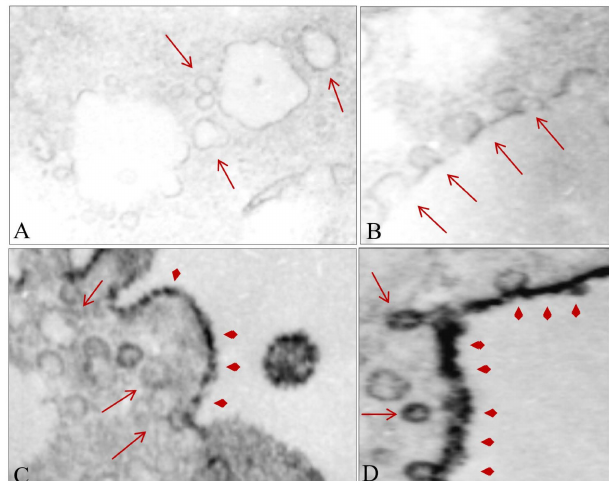
Figure 7. Effect of shock waves on cellular substructure. ( A ) Formation of new cytosolic vesicles after shock waves (arrows). ( B ) Growth of the cytosolic vesicles after incorporation of the smaller vesicles. ( C ) Growth in size and number of the newly formed cytosolic vesicles near the cell mem- brane. ( D ) Fusion of vesicles containing MSGG (arrowheads) with the cell membrane. Original magnifications, 12,000 ×